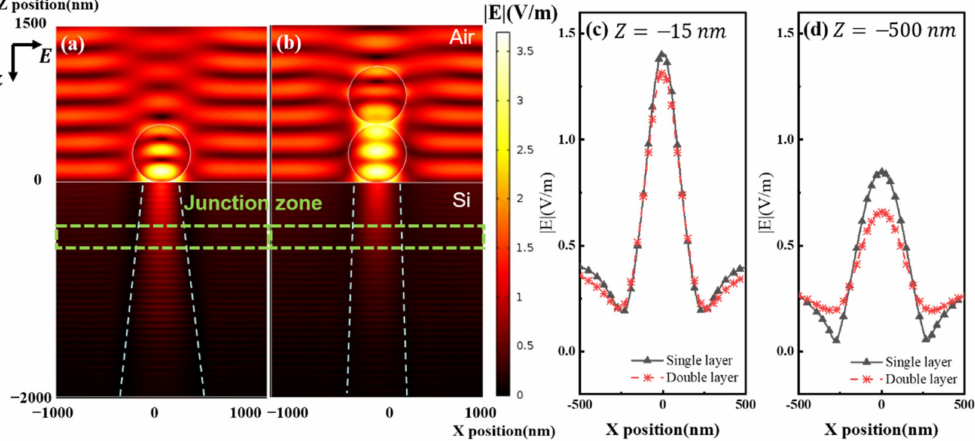
Figure 6. Electric field simulation of single-layer and double-layer nanospheres on Si solar cells: ( a ) Electric field distribution of single SiO 2 nanosphere atop Si solar cell; ( b ) Electric field distribution of vertically aligned SiO 2 nanosphere dimmer atop Si solar cell; ( c ) Electric field intensity distribution beneath the Si surface at Z = − 15 nm; ( d ) Electric field intensity distribution near the junction region of Si solar cell at Z = − 500 nm.